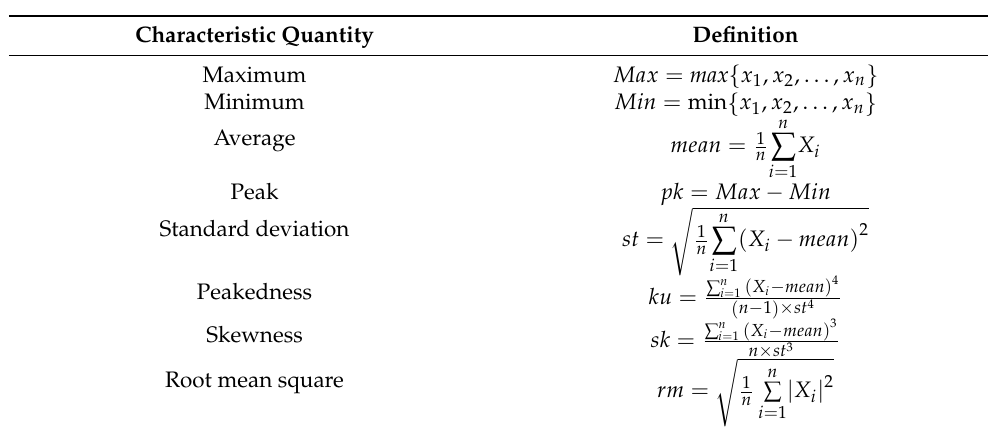
Table 2. The characteristics of